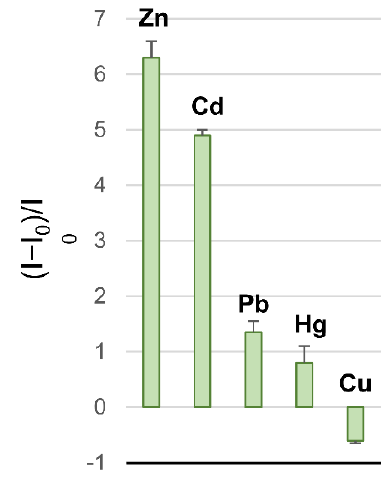
Figure 7. Bar-plot showing the emission of L upon addition of 2 equivalents of different metal cati- ons (Zn 2+ , Cd 2+ , Pb 2+ , Cu 2+ , Hg 2+ ). I and I 0 are the emission intensities of the ligand in the presence and absence of the metal ions, respectively. [ L ] = 3.2 × 10 −6 mol dm −3 (ACN – aqueous HEPES (pH 7.4) 4:1 v/v solvent mixture). λ ex = 305 nm. λ em = 385 nm (Zn 2+ ), 390 nm (Cd 2+ ), 395 nm (Pb 2+ ), 397 nm (Hg 2+ ), and 410 nm (Cu 2+ ).